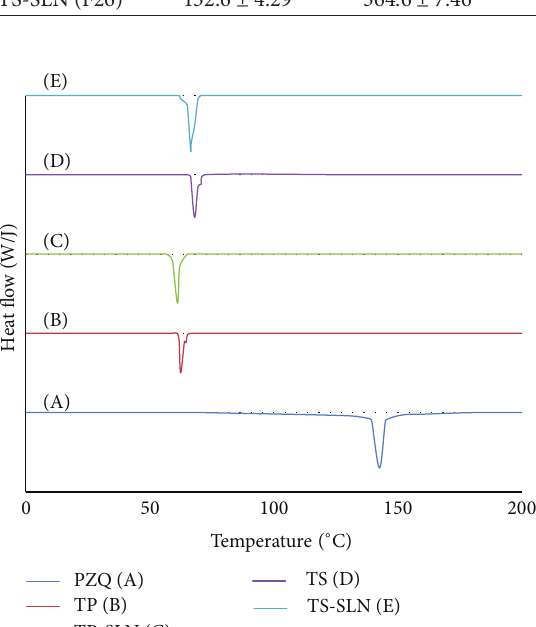
Figure 3: XRD patterns of praziquantel (A), tripalmitin (B), praziquantel-loaded TP-SLN (C), tristearin (D), and praziquantel- loaded TS-SLN